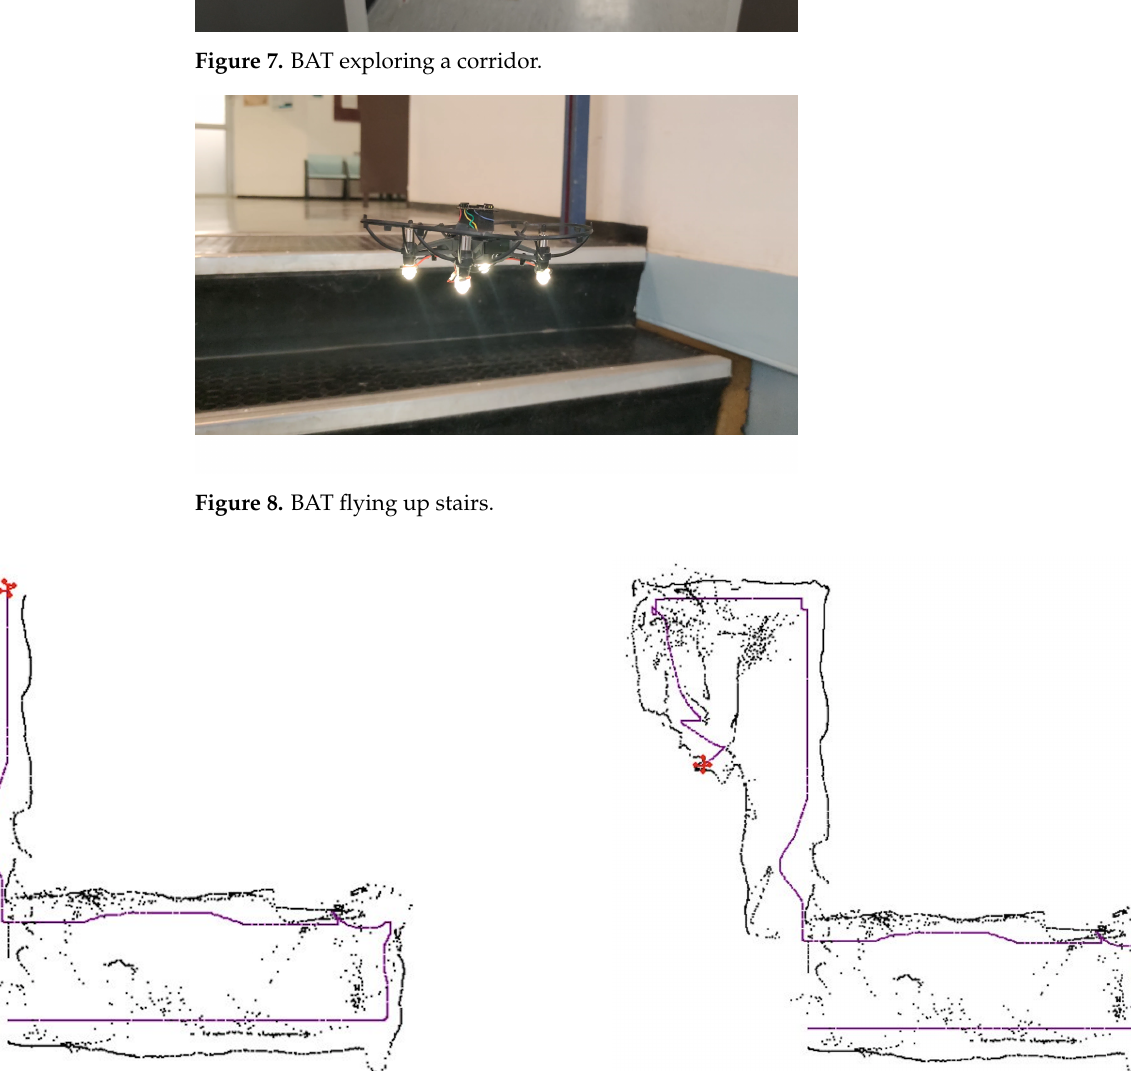
Figure 9. A 2D mapping by BAT, performed on a two story building: BAT’s position is marked in magenta; the left and right sensor-ranging are marked in black. Left : BAT has mapped the right side of the first floor and then turned right and started to go up-stairs; Right : BAT reached the second floor. Note that there are several “noisy spots" due to students following